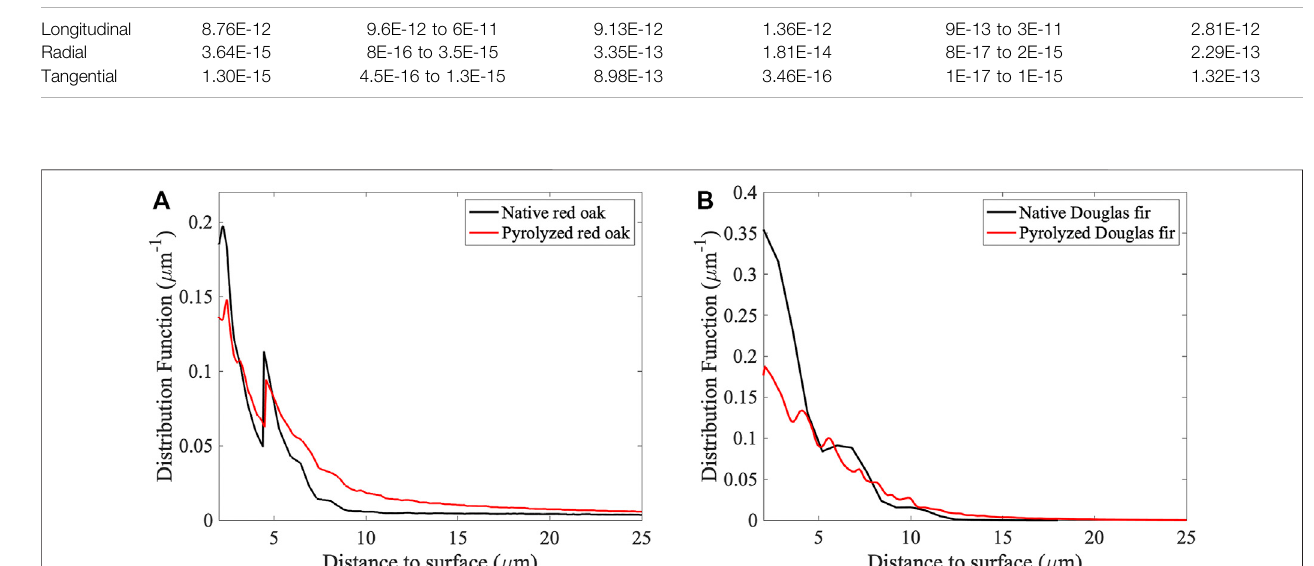
FIGURE 5 | Euclidean distance map probability density distribution of pore to surface distance of each sample. Plot (A) shows the distance to surface distribution function of native red oak, shown in black, and pyrolyzed red oak, shown in red. Plot (B) shows the distribution function of native Douglas fi r, shown in black, and pyrolyzed Douglas fi r, shown in